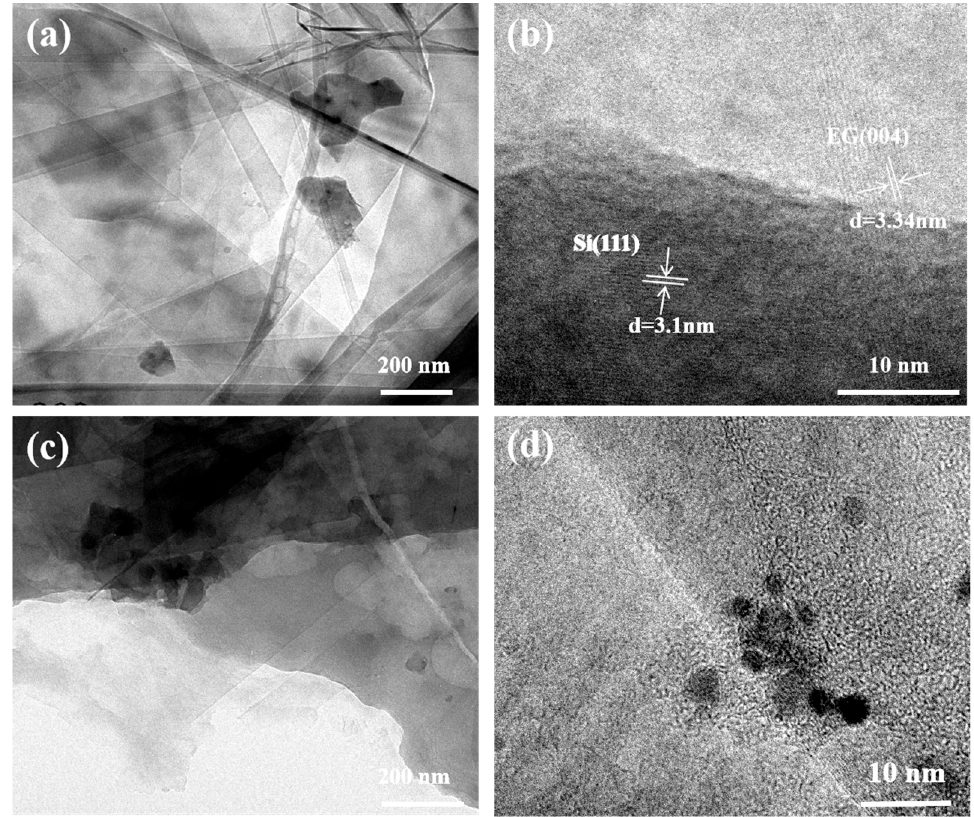
Figure 1. SEM images of ( a ) commercial nano-silicon powder, ( b ) synthesized Si@EG and ( c , d ) Si@EG@p-PANI composites.